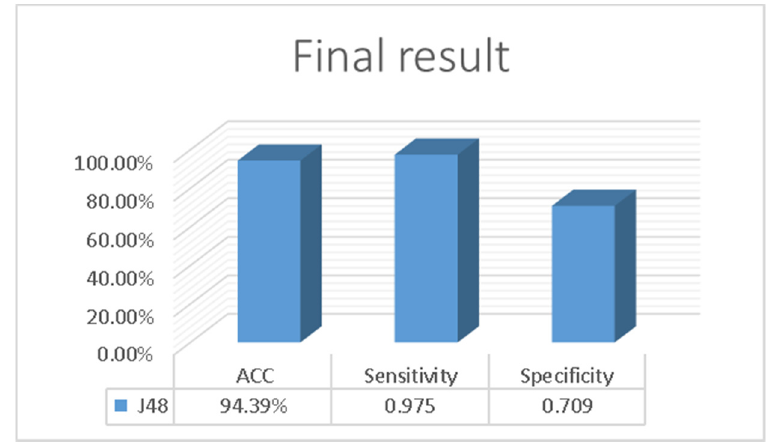
Figure 5. Compared models and methods after the last